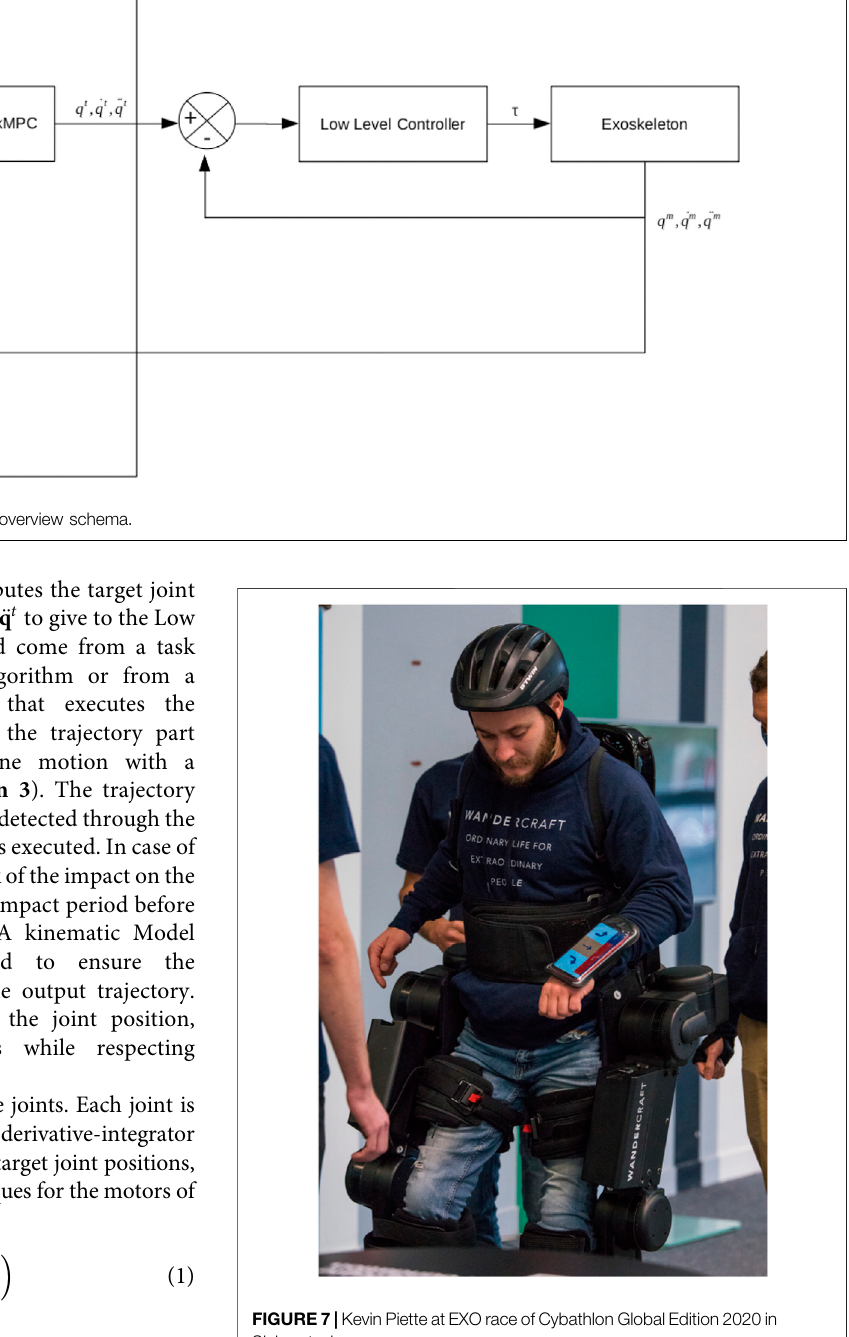
FIGURE7| KevinPietteatEXOraceofCybathlonGlobalEdition2020in Slalom